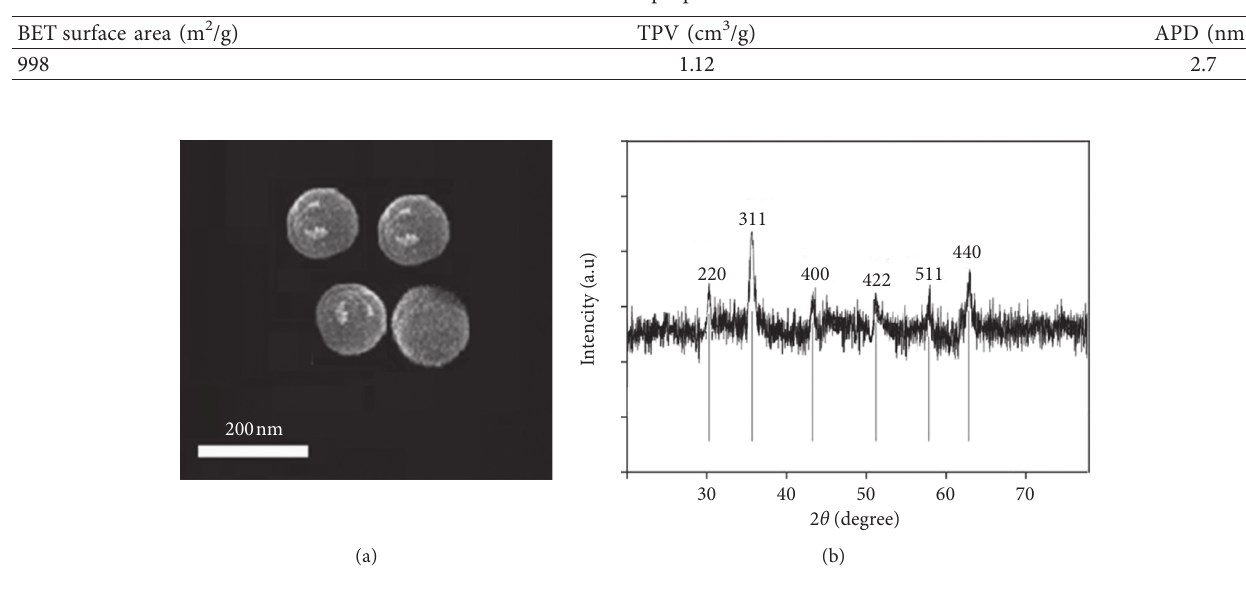
Figure 1: SEM images of FAC. Table 2: The textural properties of FAC.